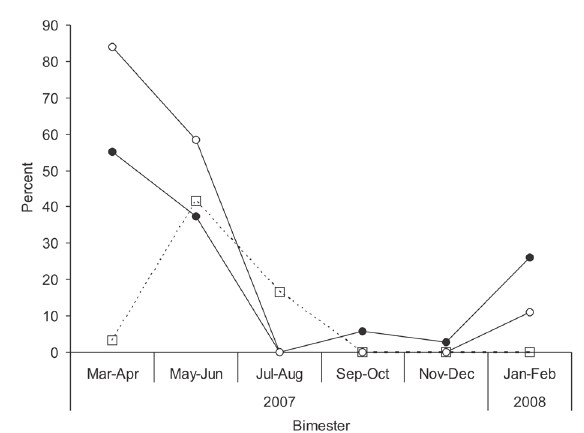
Figure 3. Aegla castro . Temporal variation in proportion of morphotype II adult males (full circles), females showing late ovarian development (empty circles) and ovigerous females (empty square and dotted